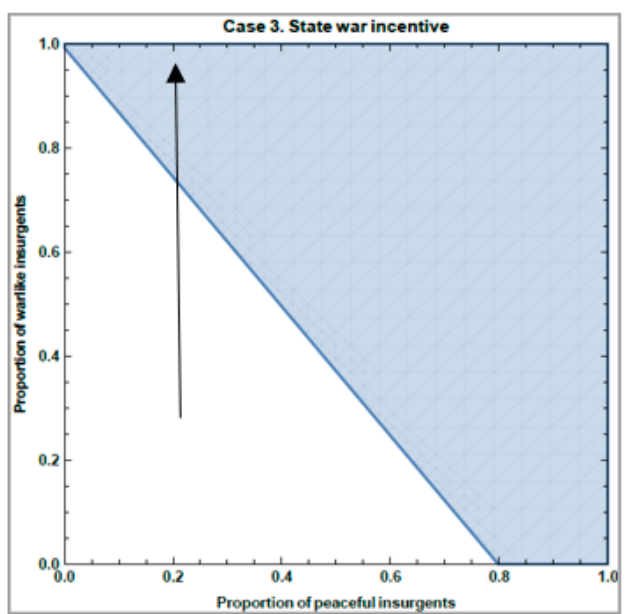
Figure 6. Fitness for State when r = 0.3, δ = 0.99, c = 0.2, and p = 0.5.